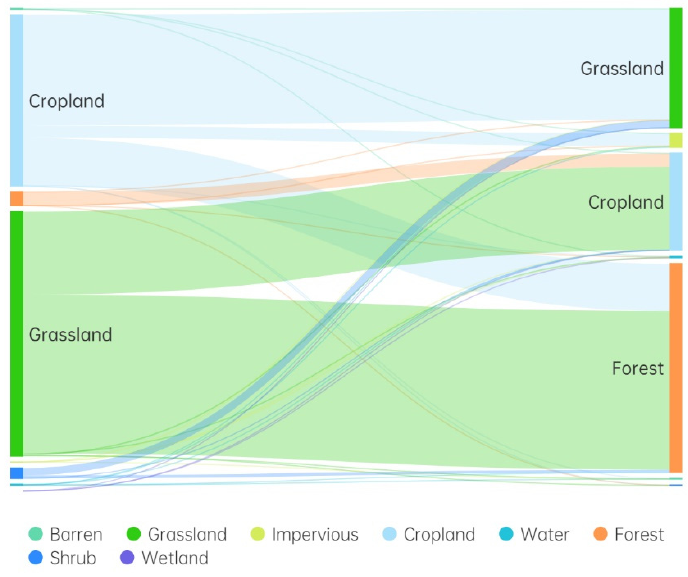
Figure 8. Shifts in land use types in Area 3 from 1985 to 2000.